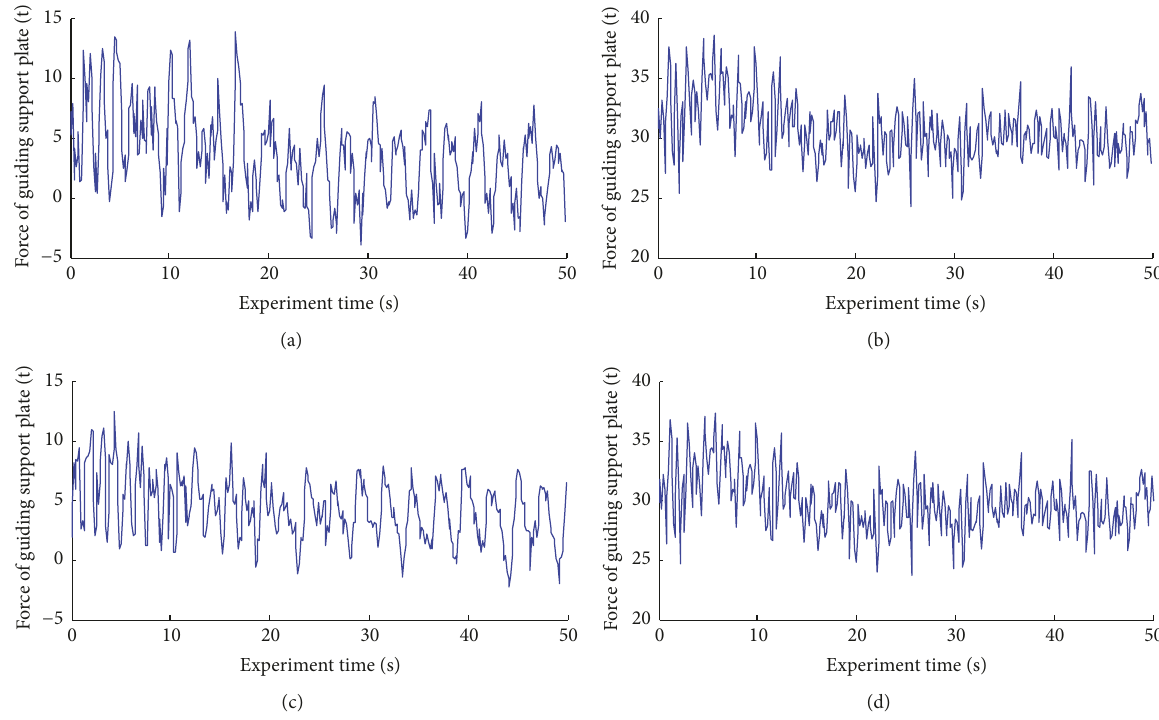
Figure 7: Time history of forces acting along 𝑌 and 𝑍 directions on guiding support plate pin shafts. (a) Force along 𝑌 direction on left guiding support plate pin shaft, (b) force along 𝑍 direction on left guiding support plate pin shaft, (c) force along 𝑌 direction on the right guiding support plate pin shaft, and (d) force along 𝑍 direction on the right guiding support plate pin